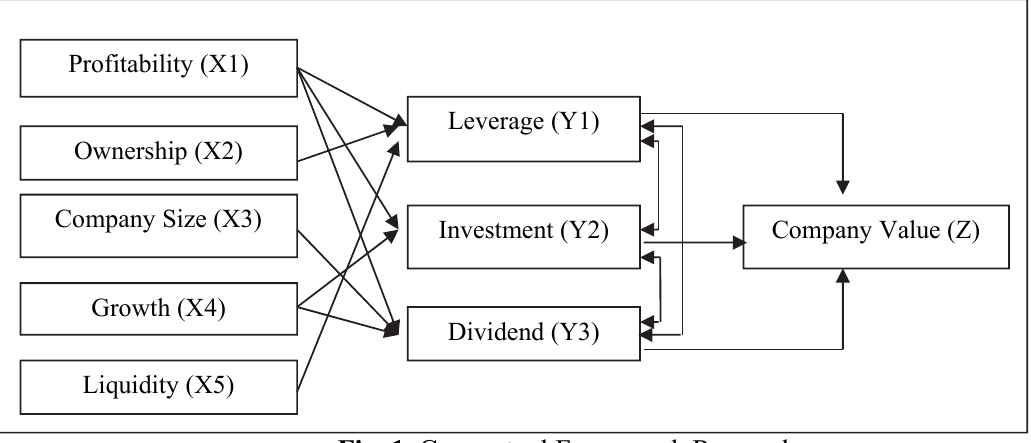
Fig. 1. Conceptual Framework